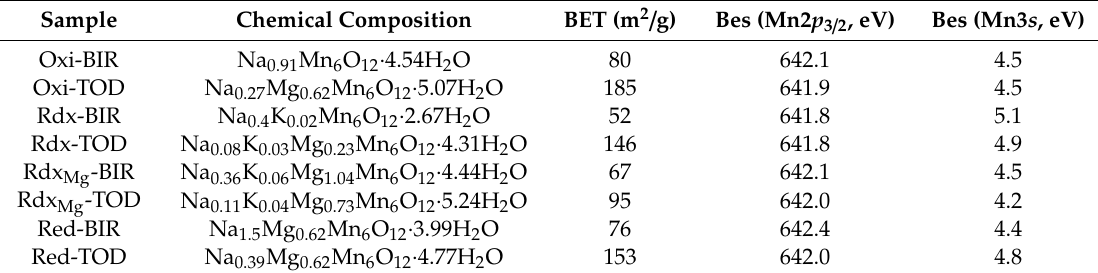
Table 2. Chemical composition, specific surface area, and X-ray photoelectron spectroscopy (XPS) results of the synthesized manganese